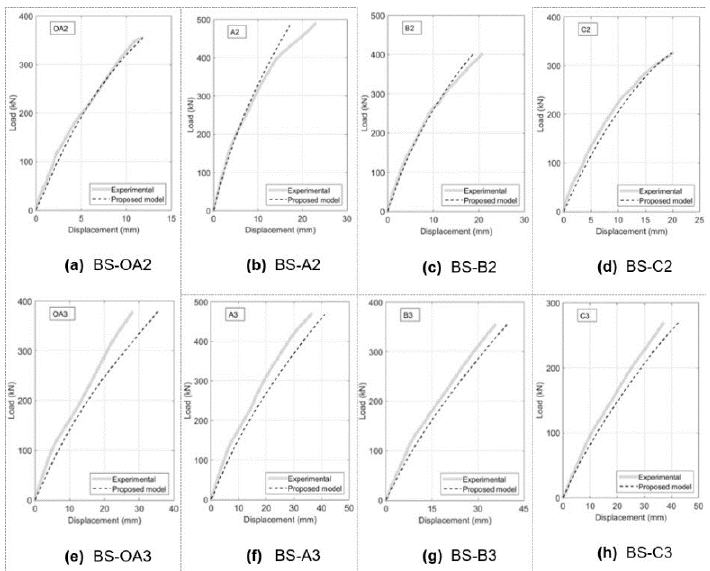
Figure 10. Maximum displacement in the BS beams.